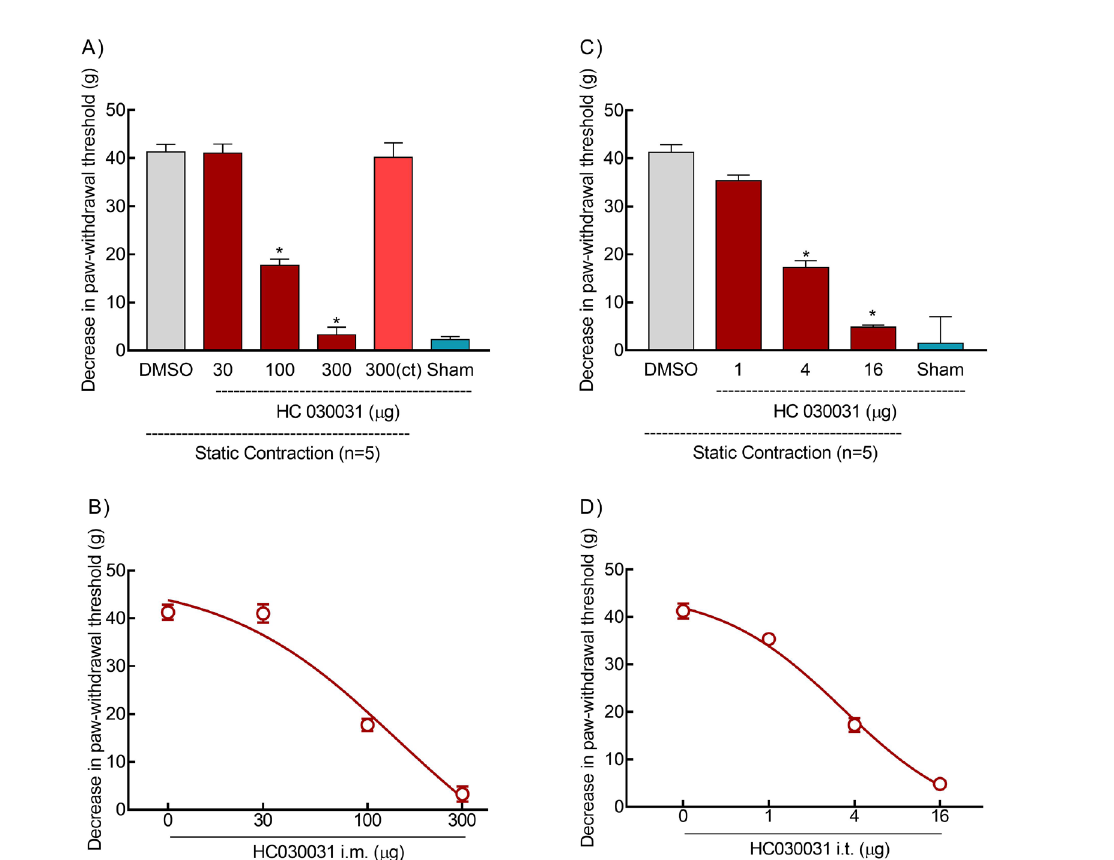
FIGURE 2 - Involvement of TRPA1 receptors in mechanical muscle hyperalgesia induced by static contraction A) Intramuscular administration of HC030031 reduced the mechanical muscle hyperalgesia induced by static contraction when administered in the ipsilateral but not in the contralateral gastrocnemius muscle. The administration of HC030031 in sham group did not affect the mechanical muscle withdrawal threshold. B) Intrathecal administration of HC030031 reduced the mechanical muscle hyperalgesia induced by static contraction. C) Dose–response analysis of the data for intramuscular administration of HC030031. D) Dose–response analysis of the data for intrathecal administration of HC030031. The symbol “*” indicates responses significantly lower than that induced by static contraction (p < 0.05, ANOVA, Tukey test). Abbreviations: ct –